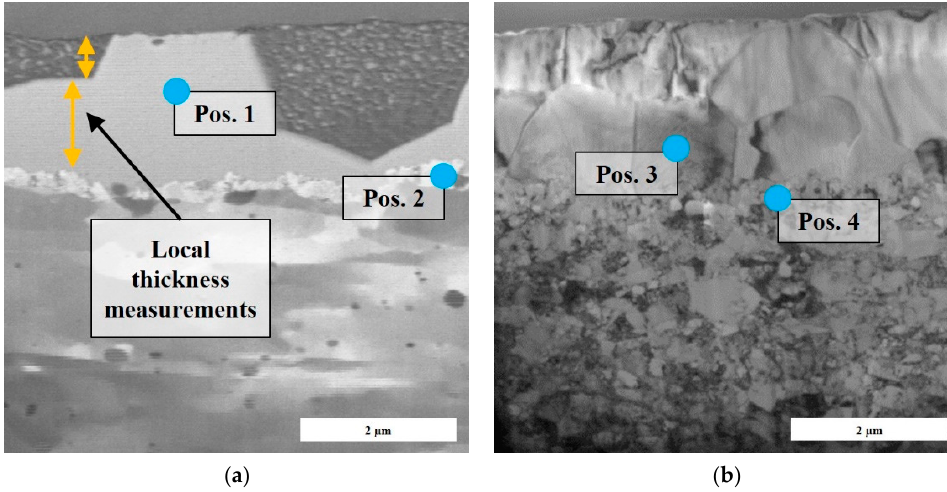
Figure 12. Comparison of the layer structure of an electrical connectors stressed by a vibration and temperature cycling test: ( a ) Ion-induced FIB analysis (voltage: 30 kV); ( b ) TEM analysis (voltage: 197